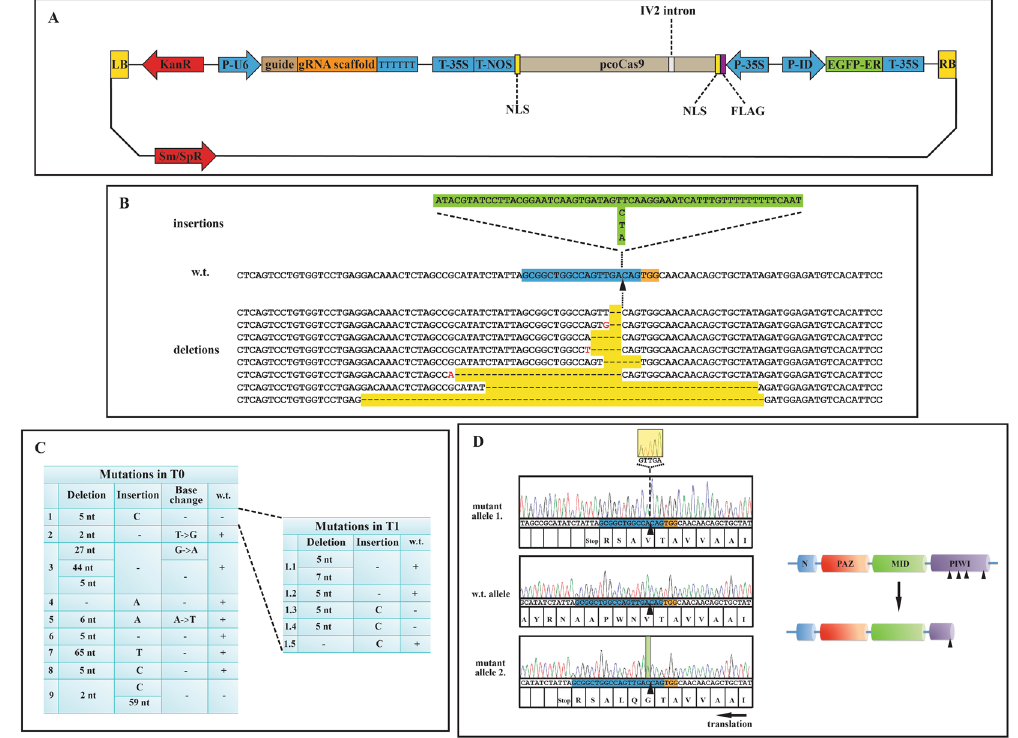
Figure 1. Generation of ago2 mutant N. benthamiana . ( A ) Schematic structure of the bi-functional Cas9- sgRNA expression plasmid used for the targeted inactivation of the AGO2 gene of N. benthamiana . ( B ) Structure of the isolated ago2 alleles. The targeted sequence of the wild-type AGO2 gene is highlighted with blue and the adjacent PAM motif with orange. In the isolated mutant alleles the insertions are highlighted with green and the deletions are with yellow. The nucleotide changes accompanying some of the deletions are indicated by red letters. ( C ) Summary of the mutations identified in the T0 and T1 transformant plants. ( D ) The mutations in the ago2 alleles of transformant lines 1.3 and 1.4 result in premature stop codons. Both alleles encode truncated, dysfunctional AGO2 proteins, which lack three out of the four catalytically essential amino acids of the PIWI